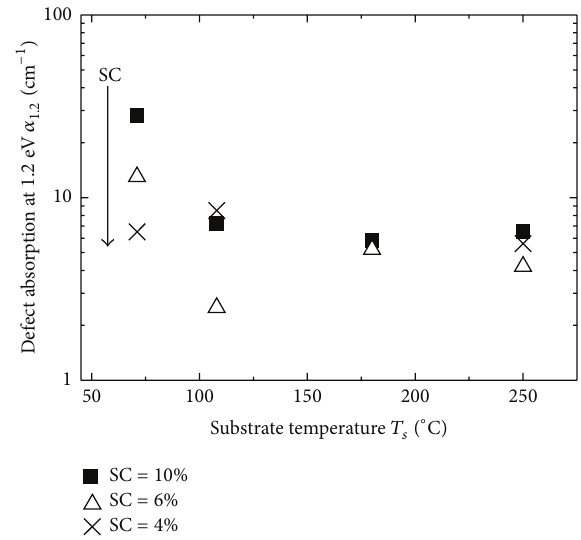
Figure 4: Band gap energy 𝐸 04 as a function of thehydrogen content of deposited a-Si:H layers with different silane concentrations.